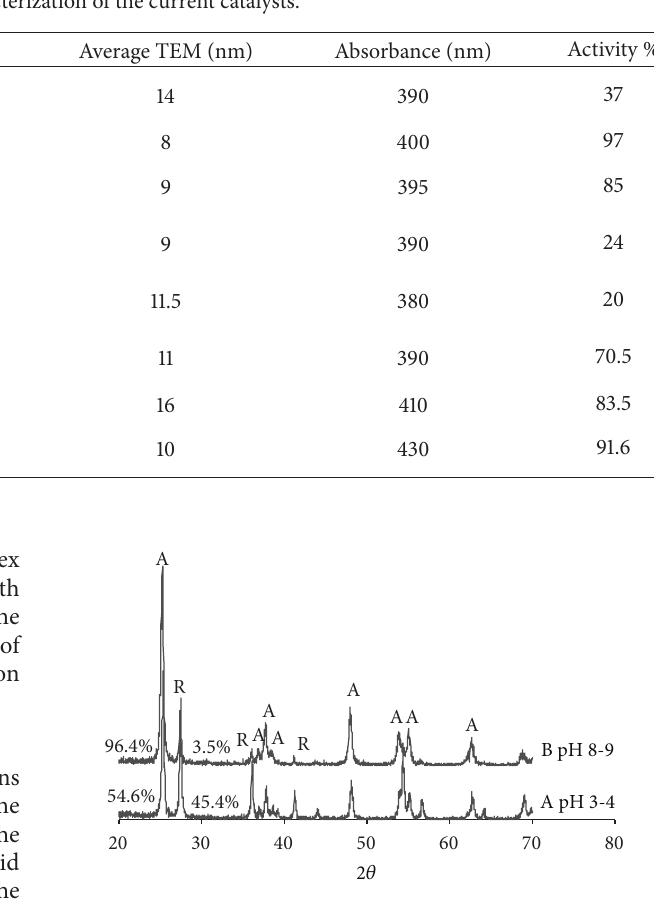
Figure 1: X-ray diffraction spectra for TiO 2 at different